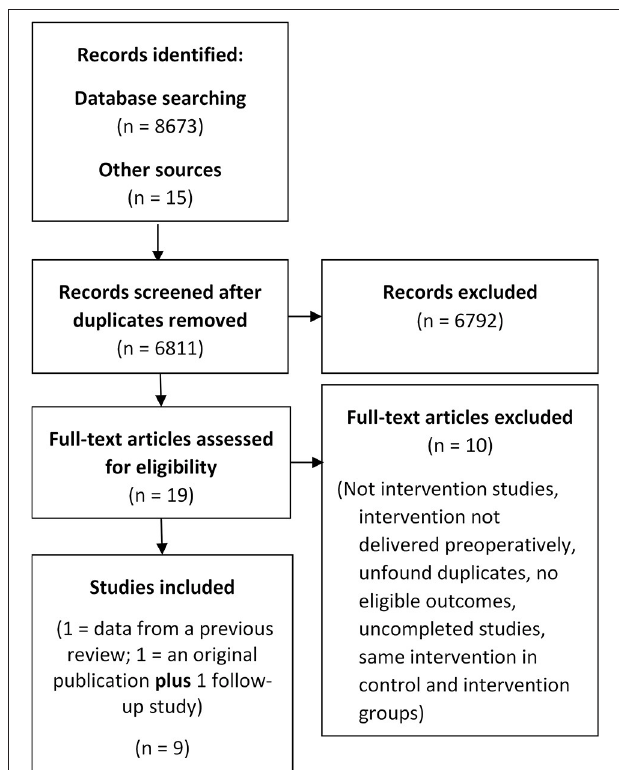
FIGURE 1 | Flow diagram of the screening